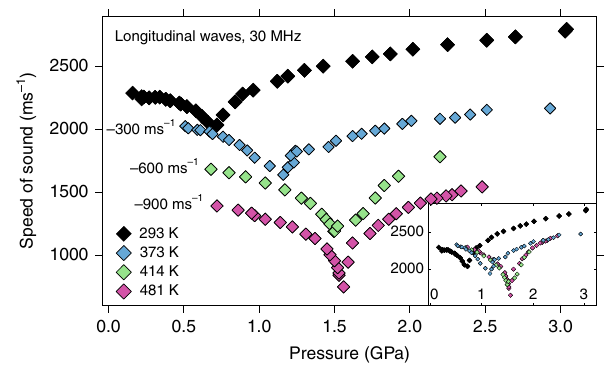
Fig. 1 Ultrasonic longitudinal velocities. The values at 293 K, 373 K, 414 K, and 481 K are displayed with an offset by subtracting 300 ms − 1 (373 K), 600 ms − 1 (414 K) and 900 ms − 1 (481 K) for better clarity. The inset shows the same data without offsets. Uncertainty in pressure ( < 0.05 GPa) and speed ( < 1%) is within symbol